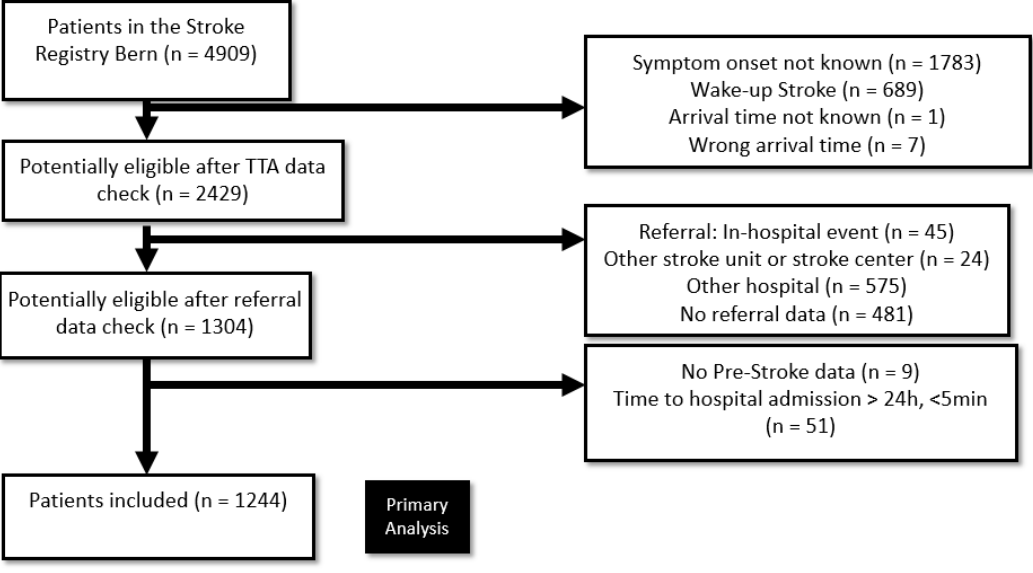
Figure 1. Inclusion Criteria in the main analysis.